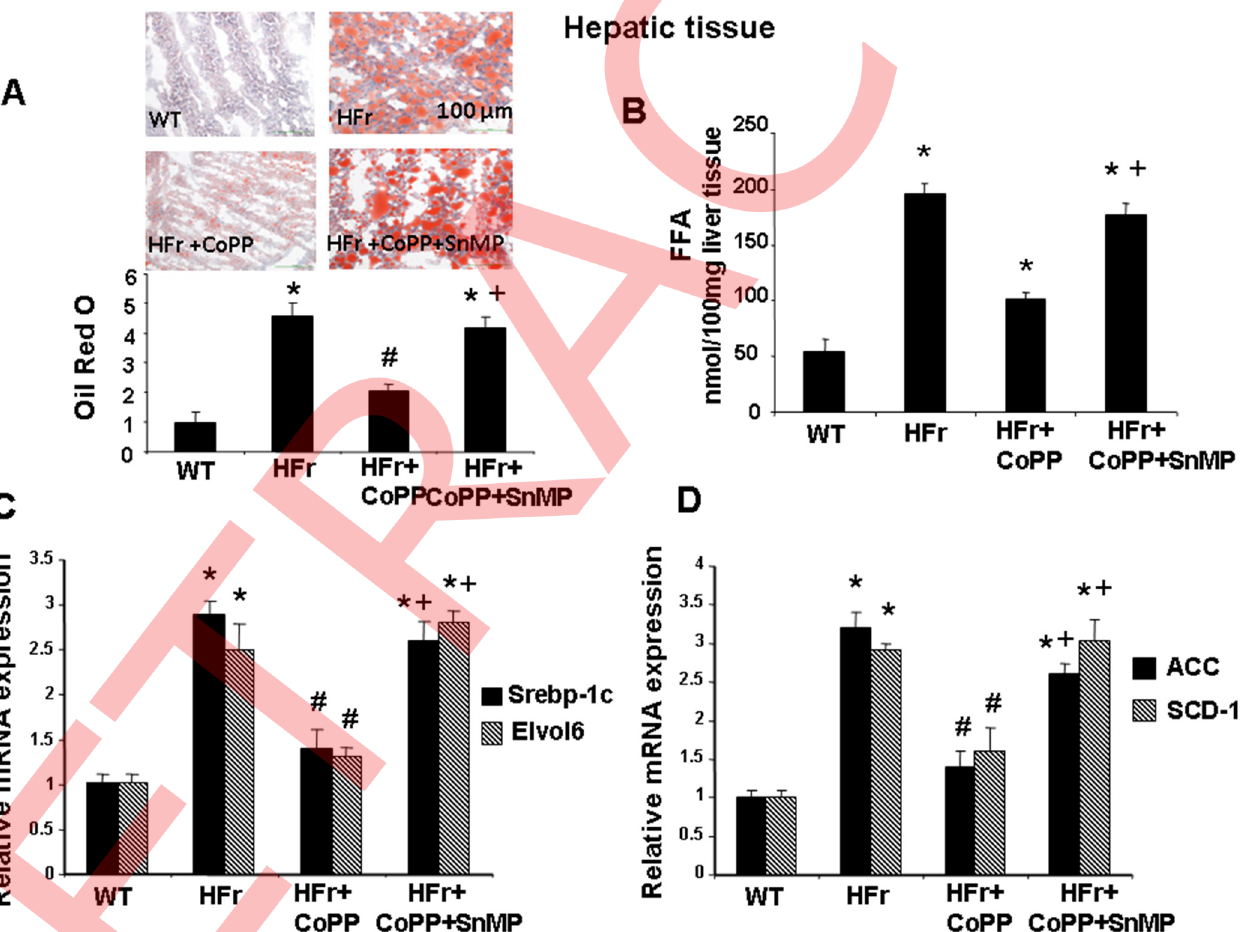
Fig 4. Effect of induction of HO-1 (CoPP) and inhibition of HO (SnMP) in mice fed a high fructose diet for 8 weeks on hepatic lipogenesis and FFA levels. (A) Oil Red O staining of lipids in liver and quantitative analysis of different groups, magnifications: 40X (n = 4). A representative section for each group is shown; (B) Hepatic FFA levels. (C) Elvol6 and Srebp-1c mRNA levels measured by RT-PCR and (D) ACC and SCD-1 mRNA expressions measured by RT-PCR. Results are mean ± SE, n = 6/group. � p < 0.05 vs CTR; # p < 0.05 vs HFr, + p < 0.05 vs HFr+CoPP. Fig 4A top left panel (WT) is excluded from this article’s CC-BY license. See the accompanying retraction notice for more information.